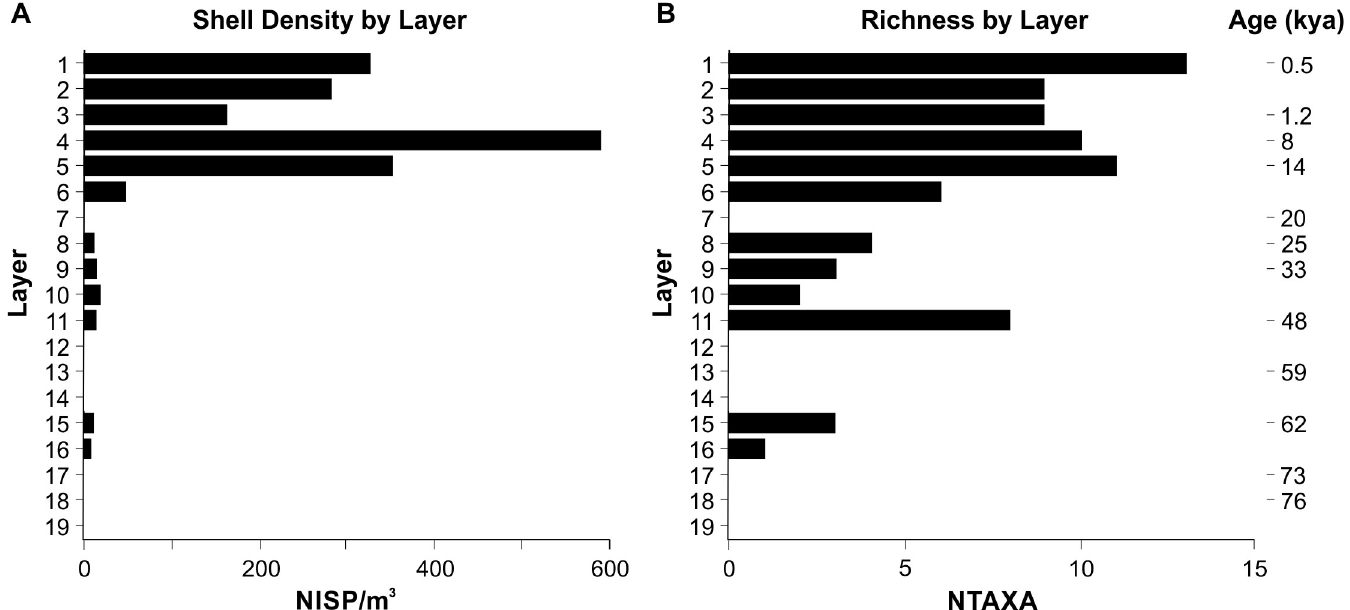
Fig 8. Shell distribution (NISP/m 3 ) through the PYS sequence by Layer (A) and PYS assemblage richness (NTAXA) by Layer (B).